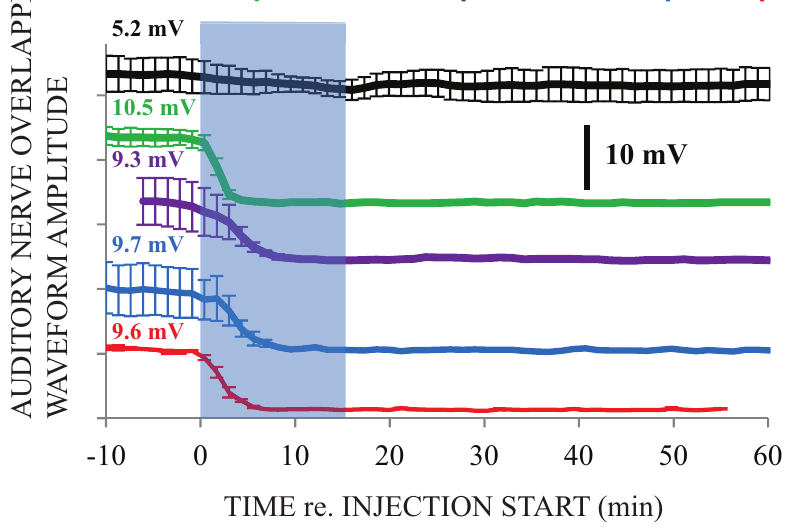
Fig 2. Auditory Nerve Overlapped Waveform (ANOW) amplitude measurements. The blue, semi- transparent rectangleidentifiesthe 15 minute durationof apical injections. The values presented on the far left of the figure are averageamplitudemeasurements from the ~10 minutes of data before the injectionstart. The ranking of measurements on the y-axis correspondsto the effect of the solution,with the measurements associated with the smallest effect at the top of the figure, progressingto the largest effect at the bottom of the figure. Salicylate, HP β CD,and M β CDtreatments caused total abolition of ANOW, but artificial perilymph alone (control) did not. N = 3 for each treatment